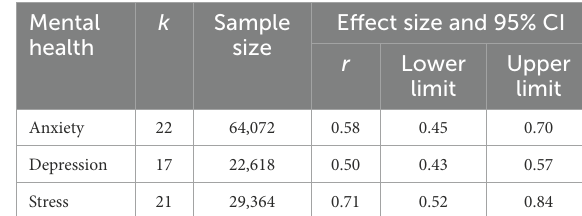
TABLE 5 The prevalence of anxiety, depression, and stress among remote learning students during the COVID-19